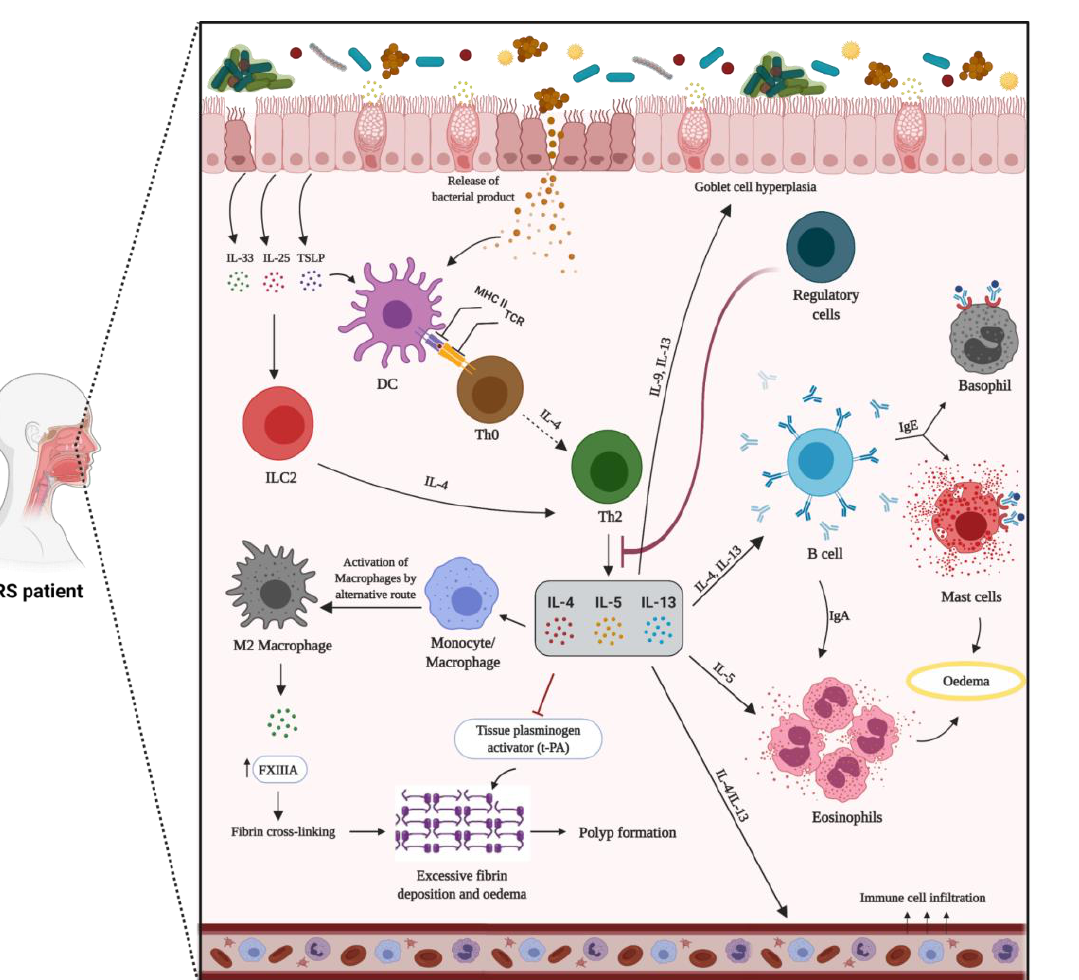
Figure 2. Mechanism of type 2 inflammation in patients with chronic rhinosinusitis with nasal polyps (CRSwNP). The dysregulated epithelial barrier results in an enhanced exposure to inhaled pathogens and allergens. In response to environmental stimuli, epithelial cells secrete inflammatory mediators, such as TSLP, IL-25, and IL-33, thus promoting the development of the type 2 immune response. In this pathway, naïve T cells (Th0) differentiate into Th2 cells, leading to the secretion of IL-4, IL-5, and IL-13. Innate immune cells, including ILC2, eosinophils, and mast cells, are activated and release type 2 cytokines that further perpetuate the ongoing inflammatory response and specific granule proteins that contribute to tissue injury. B cells and activated plasma cells are also increased, thus contributing to the enhanced local generation of antibodies. Type 2 cytokines can result in decreased tissue plasminogen activator and increased FXIIIA levels, which, in a state of an increased vascular leak, can lead to enhanced fibrin cross-linking and deposition within nasal polyps. In a type 2 inflammatory pathway with a general lack of regulatory T cells function, IL-5 triggers eosinophilia, and IL-4 and IL-13 are responsible for local IgE production by B cells. Furthermore, IL-4 and IL-13 lead to goblet cells hyperplasia and excess mucus production.